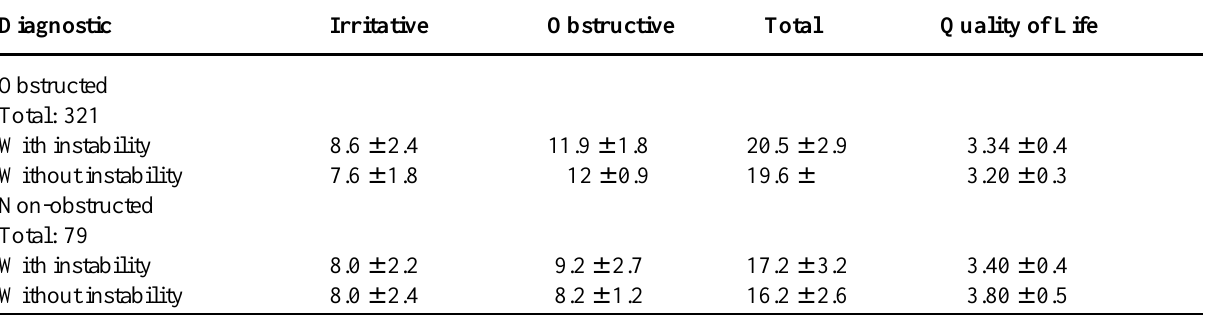
Table 2 – Characteristic of the studied population according to the urodynamic criteria in 400 men with voiding disturbances evaluated by IPSS - AUA.